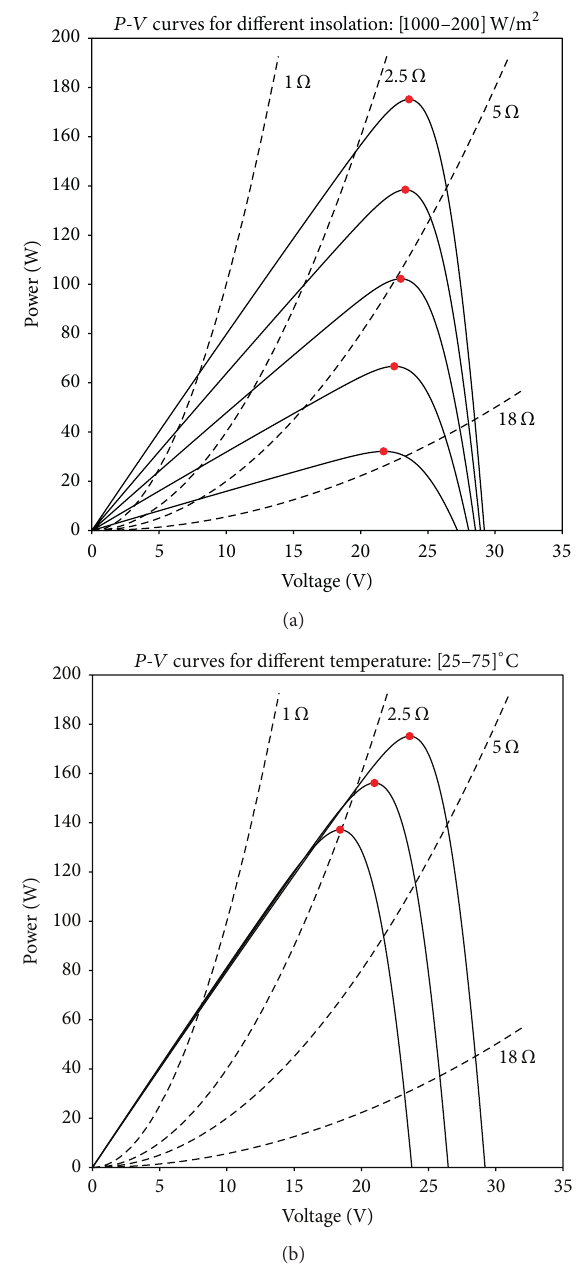
Figure 2: Working point of a generic PV panel at constant temperature (25 ∘ C), varying solar irradiance (1000–200 W/m 2 ), and electric load (a) and at constant irradiance (1000W/m 2 ), varying temperature (25–75 ∘ C), and electric load